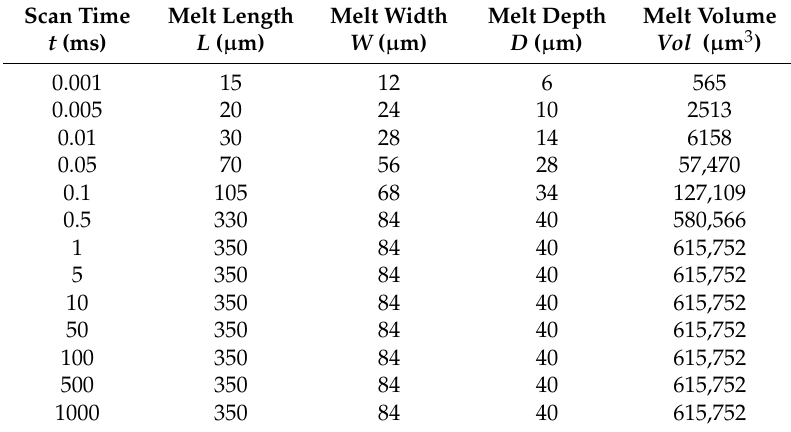
Table A1. Variables in studying molten pool growth and stabilization during a single-track scan under test 6